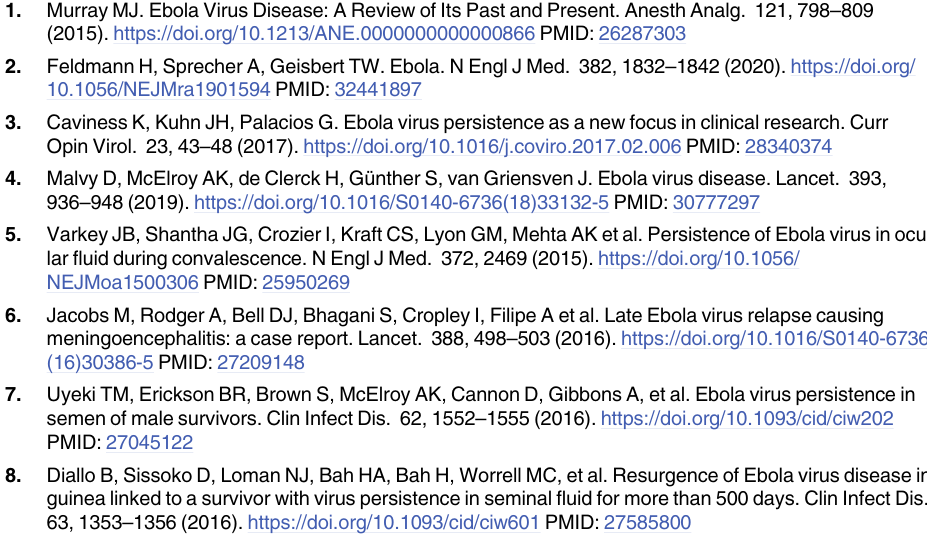
S9 Fig. Distribution of VLP- Δ GP in retina of rat. Related to Fig 7. (A) H&E staining of reti- nas from rats without injection. Magnification: × 20. Representative images of three indepen- dent experiments are shown. (B) Immunohistofluorescence analysis of EBO-VLPs in the retinal tissue using anti-VP40 antibodies (red). The white arrow indicates EBO-VLPs. Repre- sentative images of three independent experiments are shown. The fluorescent images were taken with a 60 × magnification objective lens under a confocal microscope.